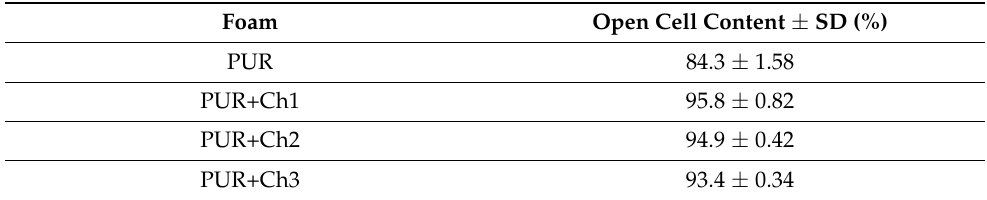
Table 2. Open cell content (with standard deviation SD) of PUR and PUR+Ch foams.